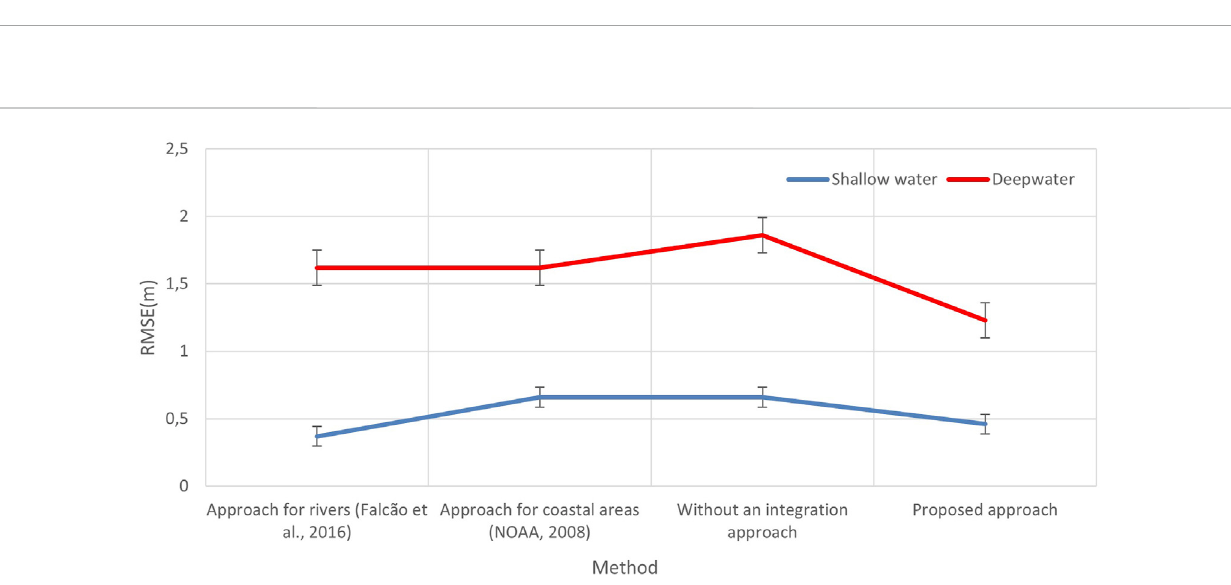
FIGURE 7 Root Mean Square Error (RMSE) between measured and predicted values in the DBM surfaces using four multisource approaches: the fi rst one dedicated to rivers (Falcão et al., 2016); the second one dedicated to coastal areas (NOAA, 2008); the third being our approach without the integration step; the fourth one being our proposed